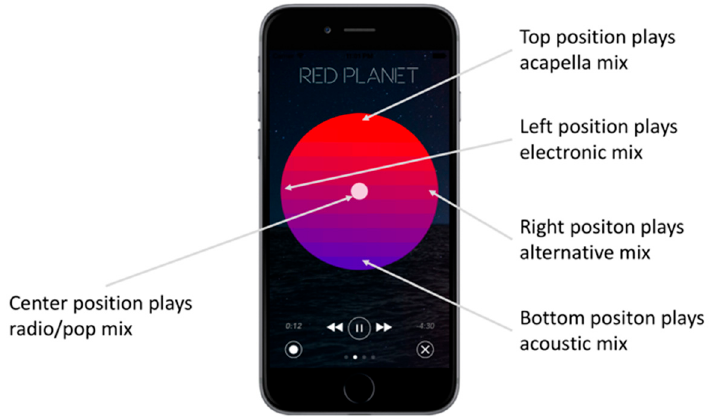
Figure 3. Daisy and The Dark ‘circle’ mixer with annotation (from the variPlay website).